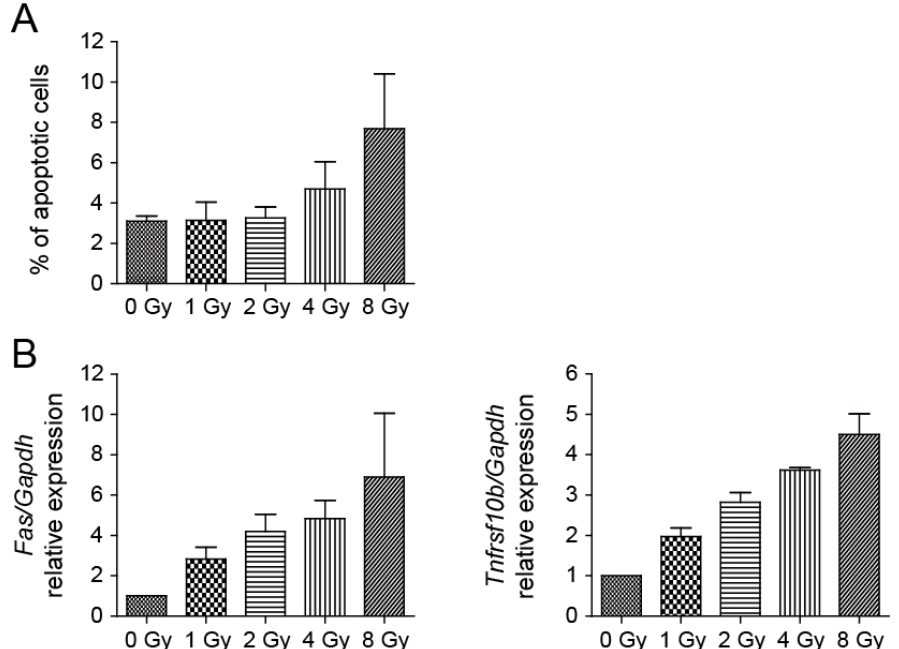
Figure 4. Irradiation of NSCs results in only a mild increase of apoptosis. ( A ) Determination of apoptosis using Caspase-3/7 Assay Kit 1 day after irradiation. Mean values: 0 Gy-3.10, 1 Gy-3.14, 2 Gy-3.26, 4 Gy-4.71, 8 Gy-7.69; p = 0.0181. ( B ) Fas and Tnfrsf10b expression in irradiated and control cells was quantified by qRT-PCR analysis one day after irradiation. Gapdh was used as a reference gene. Mean values- Fas : 0 Gy-1, 1 Gy-2.83, 2 Gy-4.20, 4 Gy-4.84, 8 Gy-6.90; p = 0.0049; - Tnfrsf10b : 0 Gy-1, 1 Gy-1.97, 2 Gy-2.82, 4 Gy-3.62, 8 Gy-4.50; p < 0.0001.